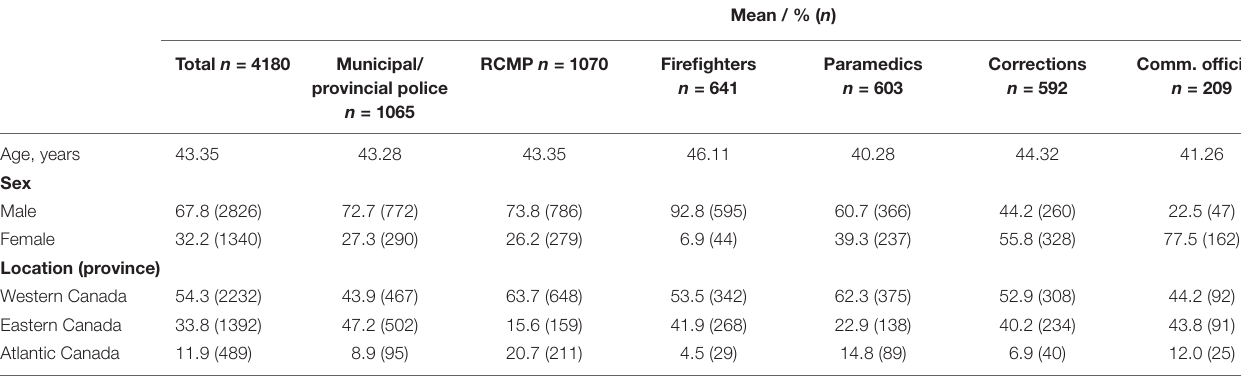
TABLE 1 | Demographics by PSP category.